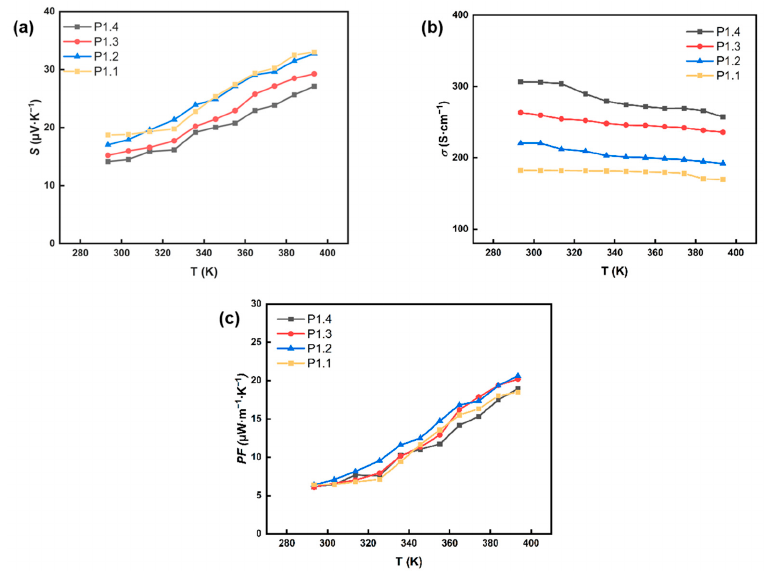
Figure 4. Relationship between temperature difference and ( a ) Seebeck coefficient ( S ), ( b ) electrical conductivity ( σ ), ( c ) Power factor (PF) of P1.1, P1.2, P1.3, and P1.4 films.